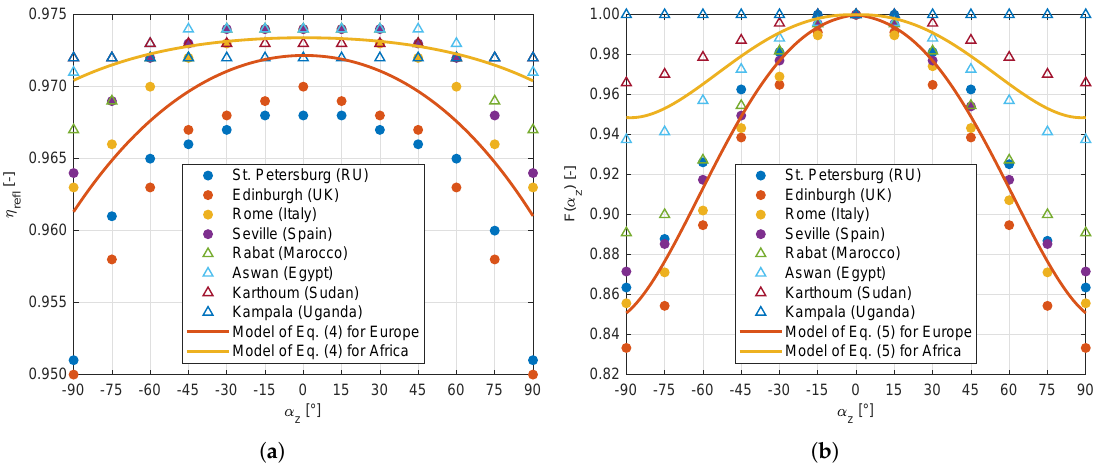
Figure 7. Results obtained from the PVGIS tool for the reflectance efficiency ( a ) and scaling factor ( b ) for the selected locations in Europe (circles) and Africa (triangles). The solid lines correspond to the model in Equation (4) in ( a ) and Equation (5) in ( b ) for Europe (red) and Africa (yellow), with the model coefficients reported in Table 3 for the two